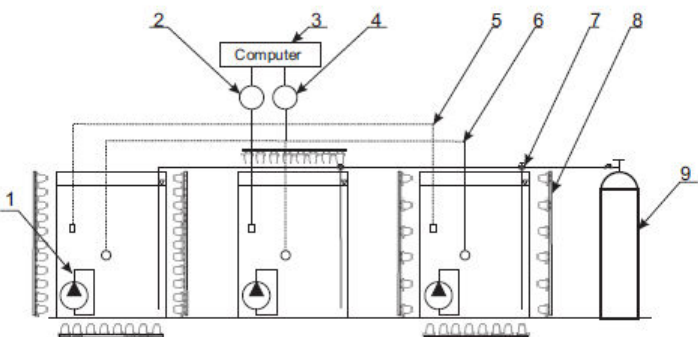
Figure 1. Scheme of the test bench: (1) circulation pump, (2) temperature meter, (3) computer, (4) photosynthetically active radiation (PAR) meter, (5) thermocouple, (6) PAR probe, (7) dosing regulator CO2, (8) lighting system, (9) CO2 feeding system. Source: own work.